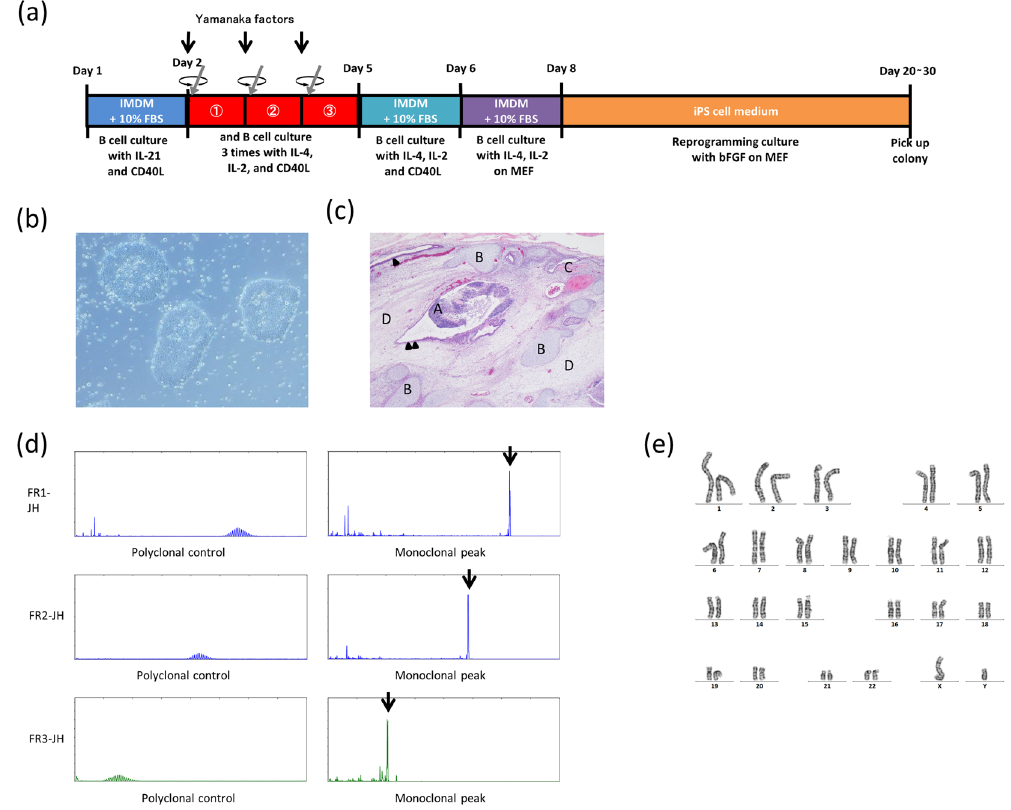
Figure 2. Generation of B cell derived iPSC (BiPSC). ( a ) Time schedule and protocol of BiPSC generation. ( b ) Colony formation of a representative BiPSC13 (x200). ( c ) Teratoma derived from human BiPSC13 (x4). Nine weeks after the injection of BiPSC13, teratomas were dissected from bulging lower abdomen. Hematoxylin and eosin staining of the teratoma. (A) Nerve tissue (ectoderm), (B) Cartilage tissue (mesoderm), (C) Bone tissue (mesoderm), (D) Connective tissue (mesoderm) and endodermal epithelial tissues with a lumen structure (Arrow head), and ectodermal epithelial tissue consisting of ependymal cell-like cells (Double arrow heads). ( d ) Monoclonal VDJ rearrangements of the IgH gene (Arrows) in BiPSC13 detected using PCR. ( e ) Normal G-banding karyotype of